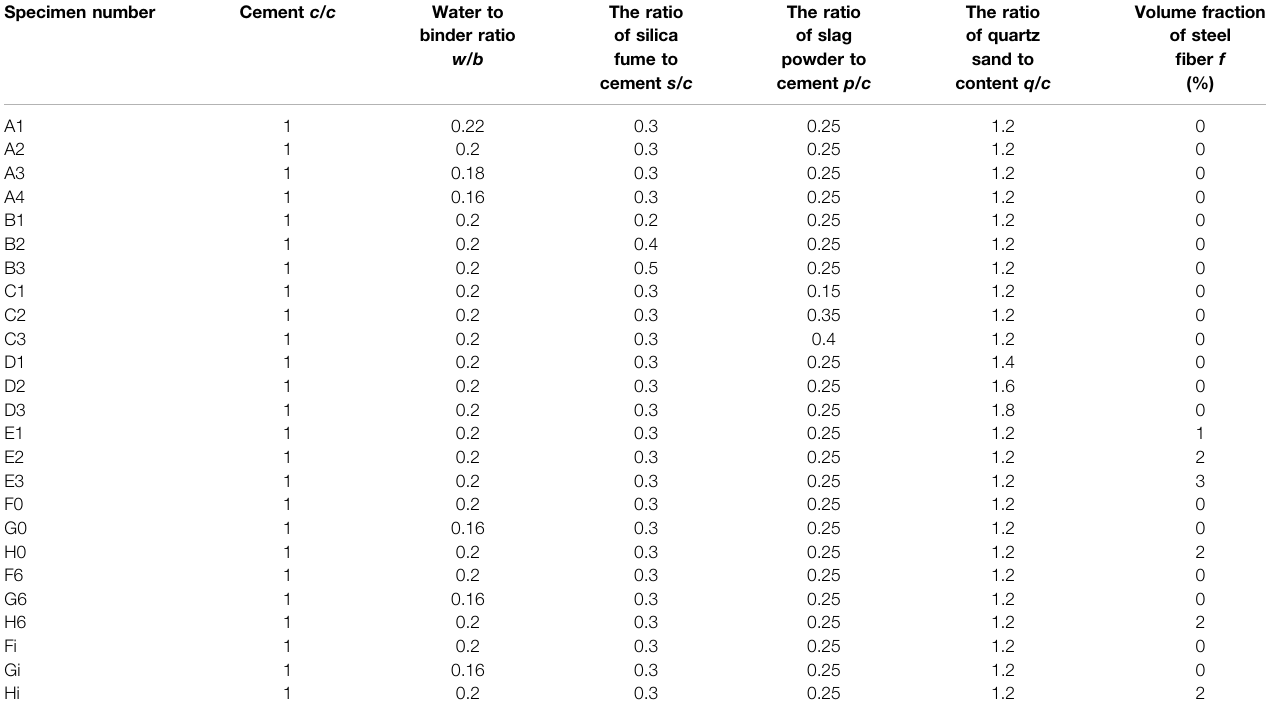
TABLE 1 | The main parameters of RPC specimens. Specimen number